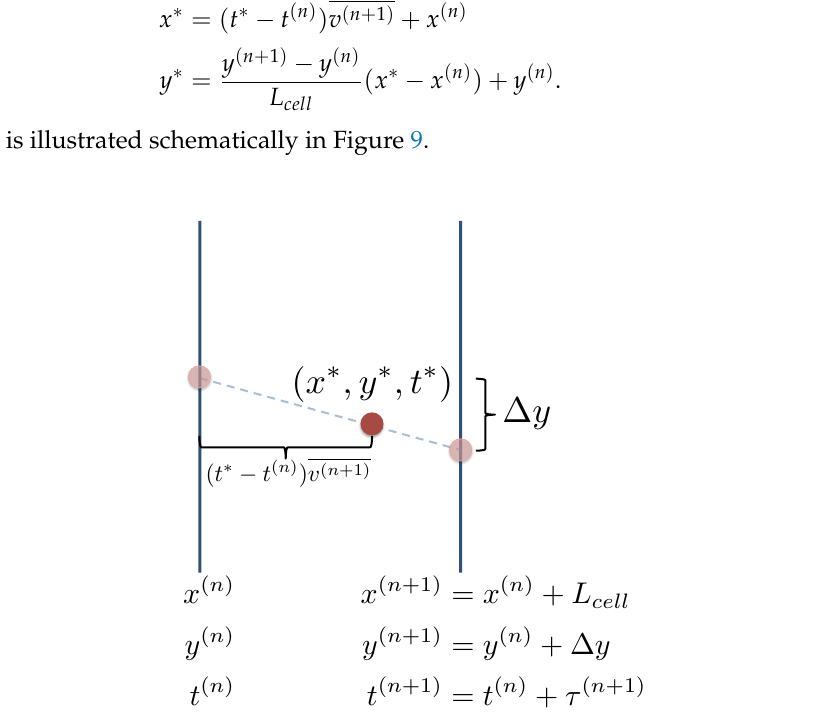
Figure 9. Illustration of the downscaling procedure Method 2 in the y direction. A particle is in Cell n + 1 and will travel through that cell over an amount of time τ ( n + 1 ) . The particle’s x location is determined using the method described in Section 4.1. We predict the particle’s y location at time t ∗ using Method